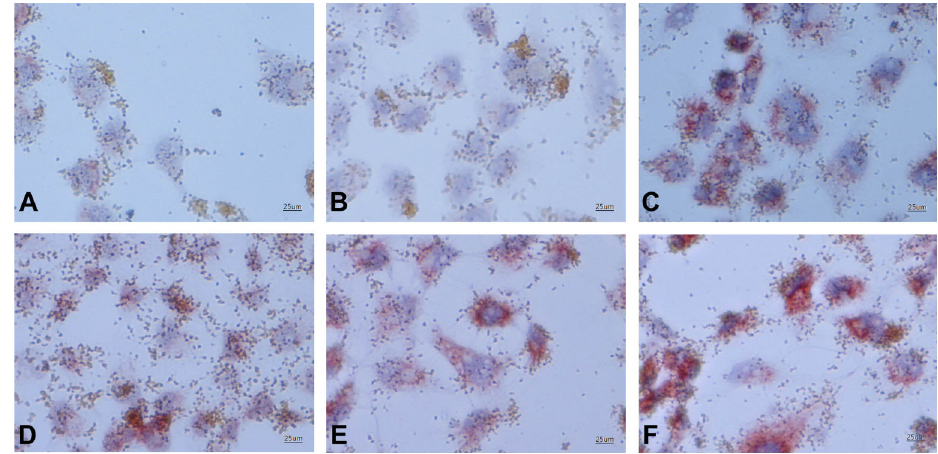
Figure 11. Immunocytochemical images (400 6 ) of Bax expression in SMMC-7721 hepatoma cells. A , Control group A (RPMI 1640 culture medium only); B , spiking group (8 g/L Fe 2 O 3 , no radiation); C , 2 g/L Fe 2 O 3 MFH group; D , 4 g/L Fe 2 O 3 MFH group; E , 6 g/L